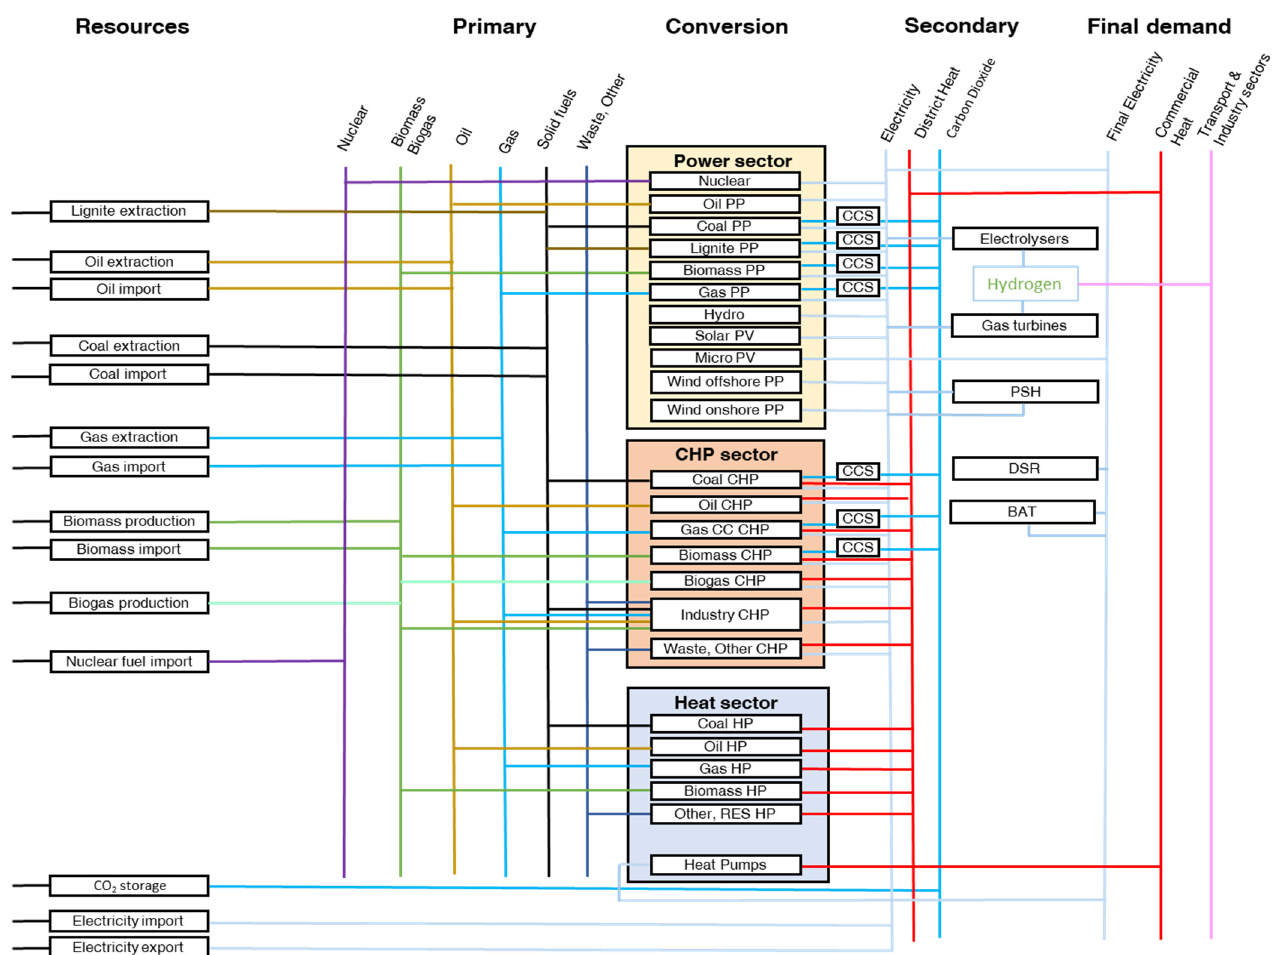
Figure 3. Schematic of energy chain implemented in the MEESA model. Source: own elaboration [48]. The model disaggregates demand in the optimised year for electricity and heat into 18 time slices based on historical data of the demand profile for each country according to seasons (winter and summer), types of days (low-, medium-, and high-demand or different RES productivity), and time of day (day, night, and peak demand period). This allows one to take into account both the average and extreme states of operation of PV and wind sources. This provides a basis for determining the mode of operation of individual units in the system. This solution also enables an analysis of the level and direction of intersystem electricity exchange, with each region being one node. The model ensures this by providing a 15% power margin. Each technology has a defined availability, e.g., photovoltaic 0%, wind onshore 10%, wind offshore 15%, BECCS CHP 70%, BECCS PP 80%, nuclear PP 90%, GAS PP 95%, and pumped-storage PP 100%. The MEESA model is integrated with an economic model that determines the economic impact of energy and climate policy changes and with sectoral models (TR 3 E and EPICA). The d-PLACE model is a recursive dynamic global and multisector general equilibrium (CGE) model. The d-PLACE model is based on a static CGE model. The input data used to calibrate the base year (2015) come from the Global Trade Analysis Project (GTAP-10) database. The baseline scenario (up to 2050) is consistent with the external projections of changes in GDP, emission limits for the EU, and emission limits for the rest of the world. The effects of the individual regulations analysed in the climate policy scenarios are presented in this model as deviations from the baseline scenario. A characteristic feature of this model is the highly detailed elaboration of GHG emissions.